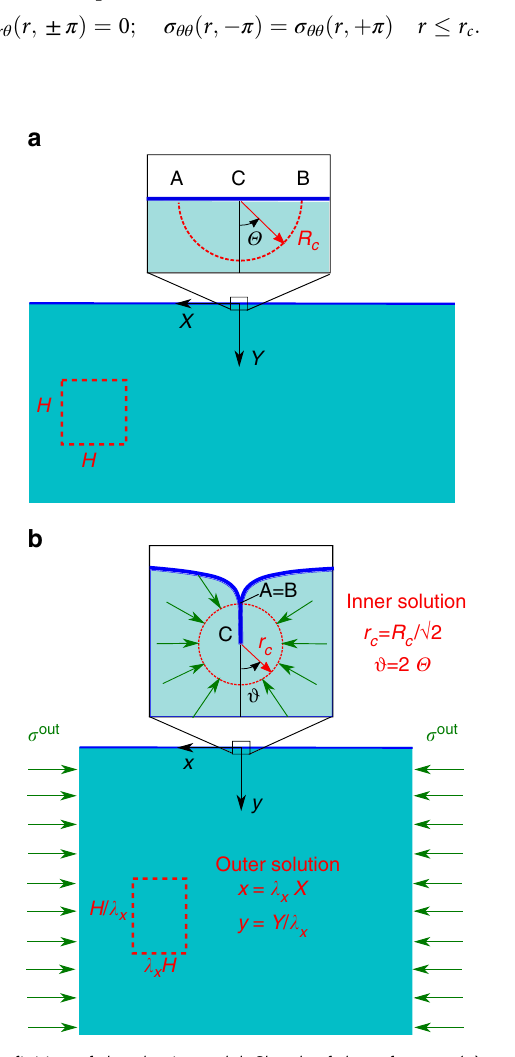
Fig. 2 De fi nition of the elastic model. Sketch of the reference ( a ) and current ( b ) con fi gurations, with the corresponding coordinate systems, of a soft elastic half-space subjected to a controlled fi nite axial stretch λ x , sustained through an axial compressive stress σ out . The insets show the inner solution, de fi ning a small crease nucleating in the point C , in which an half circle of radius R c is mapped into a full circle of radius r c (dotted red lines), with self-contact along the lines AC and AB. The far- fi eld outer solution de fi nes an af fi ne transformation, deforming a square of length H into a rectangle of sides λ x H and H = λ x (dashed red